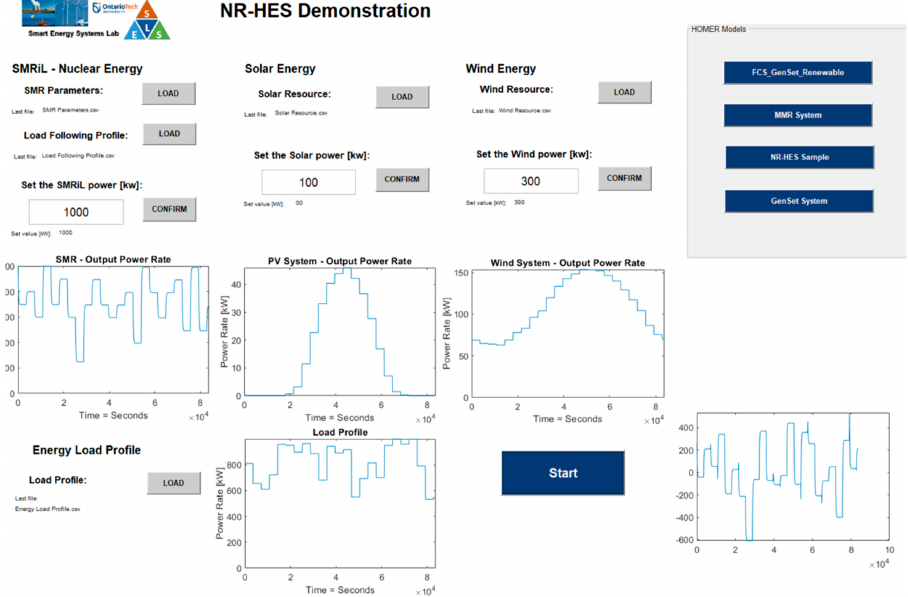
Figure 22. N-R HES demonstration.